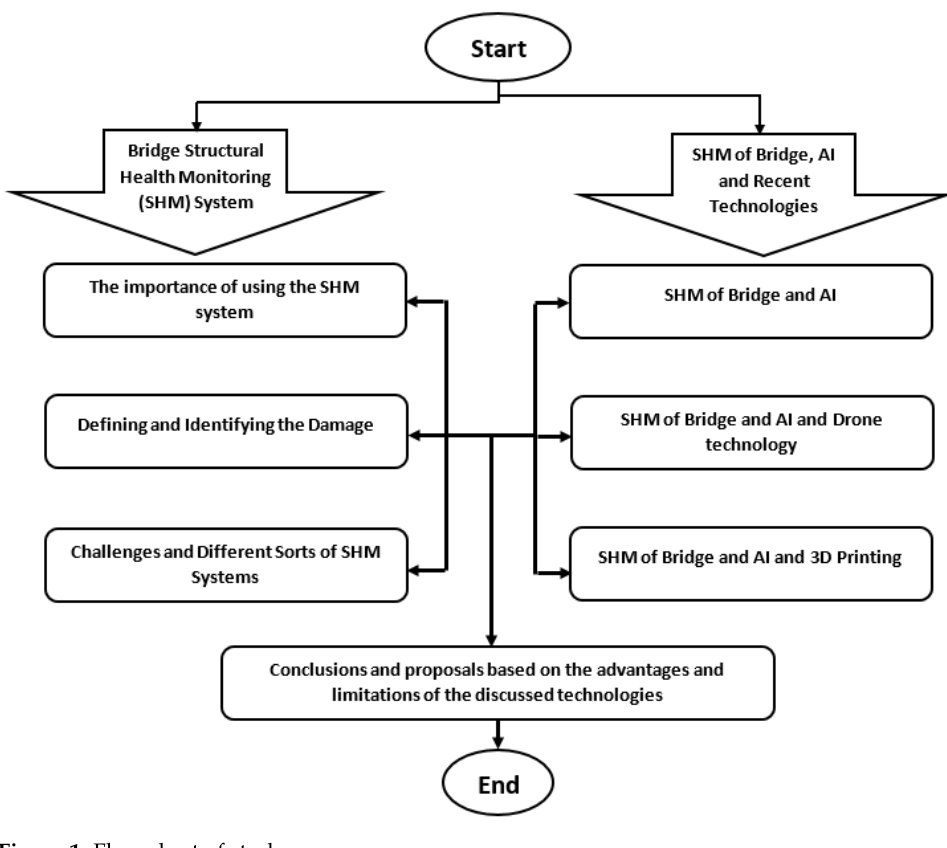
Figure 1. Flow chart of study.